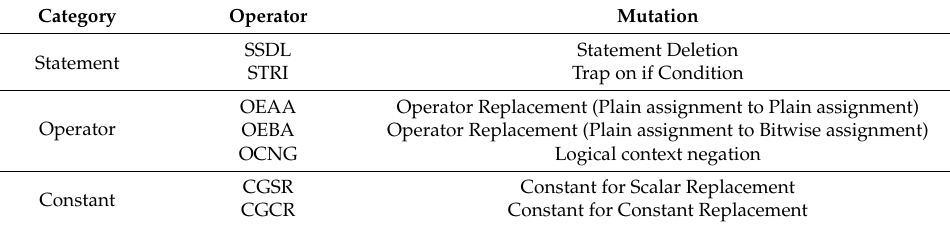
Table 4. List of mutation operators.